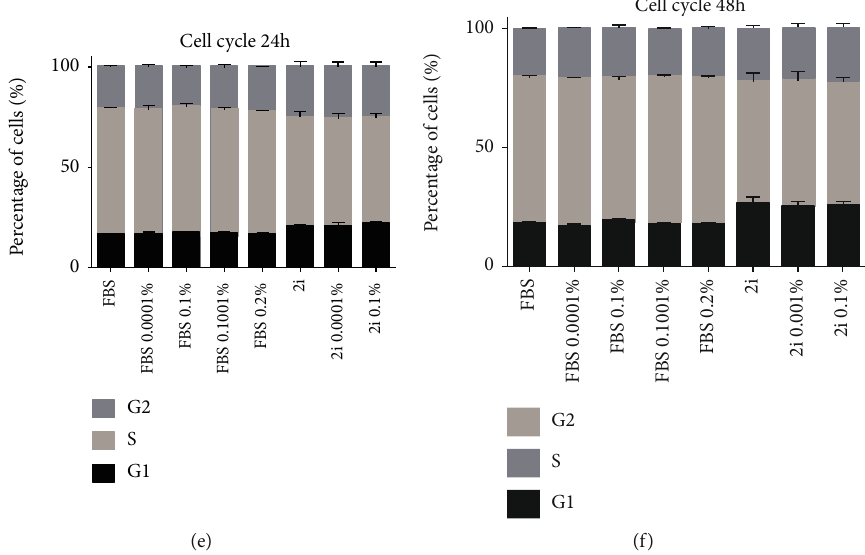
Figure 2: DMSO does not a ff ect apoptotic and cell cycle pro fi les in cultured mESCs. The percentage of apoptotic/necrotic cells was assessed via Annexin V and PI staining after 24 and 48h culture in the presence/absence of DMSO. (a) Flow cytometry dot plot from necrosis/apoptosis detection at the 48 h time point. Four populations were identi fi ed: live cells (negative for both Annexin V and PI), early apoptotic cells (positive for Annexin V and negative for PI), late apoptotic cells (positive for both Annexin V and PI), and dead cells (only positive for PI). (b) Percentage of cells in the de fi ned populations at the 24 h time point. (c) Percentage of cells in the de fi ned populations at the 48h time point. Four independent experiments were conducted. (d) Flow cytometry histograms obtained from the analysis of cell cycle using PI staining at the 48h time point. (e) Percentage of cells in each cell cycle phase at the 24h time point. (f) Percentage of cells in each cell cycle phase at the 48h time point. At least fi ve independent experiments were performed. Results are expressed as means ± SEM . Statistical signi fi cance was considered when ∗ p ≤ 0 : 05